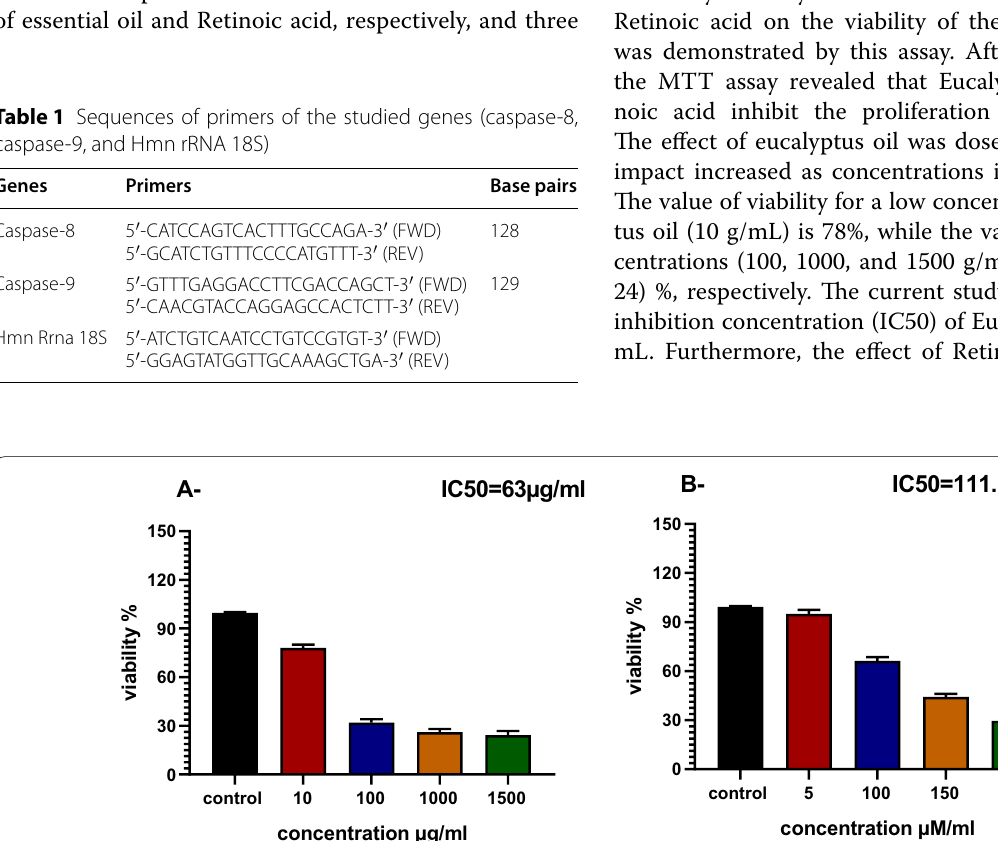
Fig. 1 Effect of both substances on the viability of Esophagus cancer cell line SK‑GT‑4 after 72 h of treatment ( n oil and B treatment with retinoic